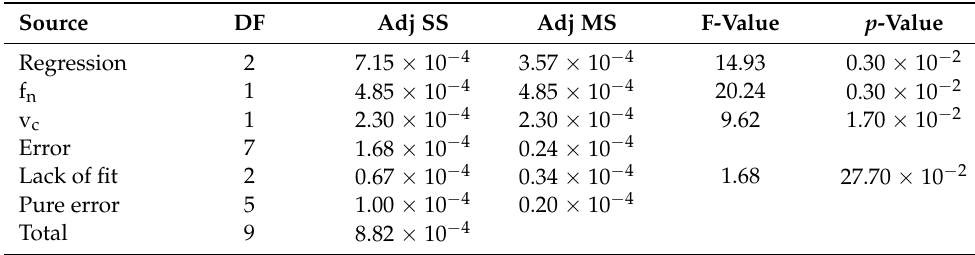
Table 12. Analysis of variance.